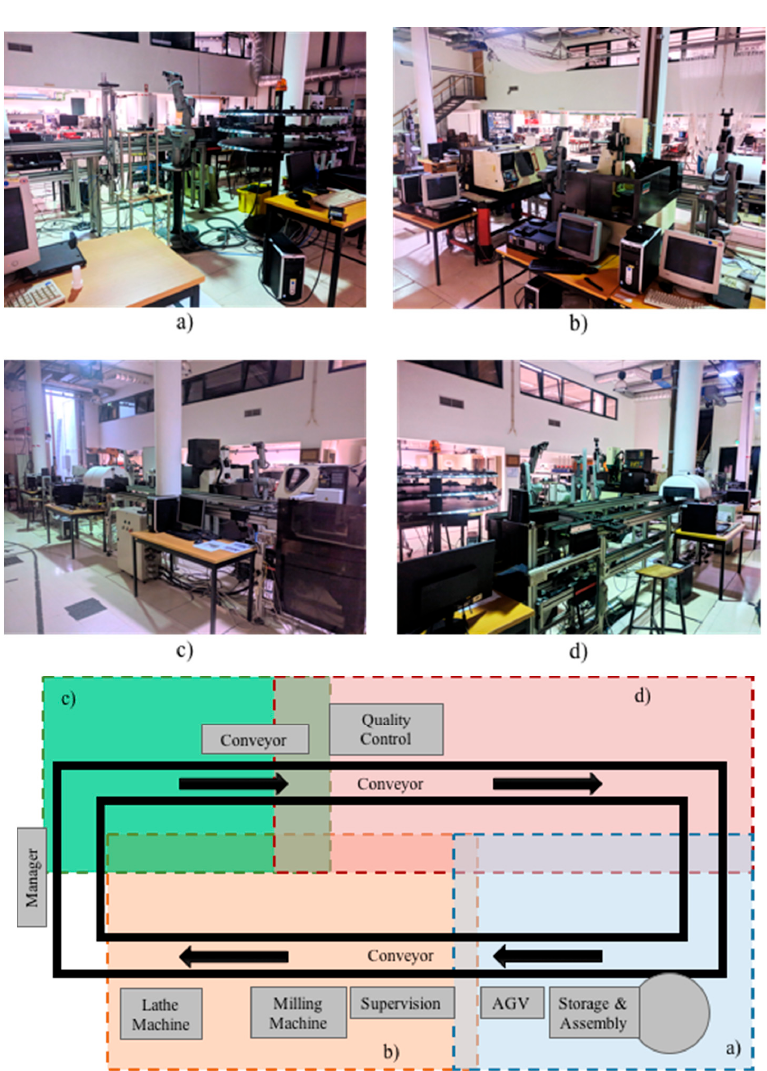
Figure 4. Hardware and the manufacturing machines of all the stages. (a) corresponds to the AGV and the Storage & Assembly stages; ( b ) corresponds to the Lathe and Milling machines as well as the Supervision center; ( c ) corresponds to a Conveyor segment; ( d ) corresponds to the quality control unit.